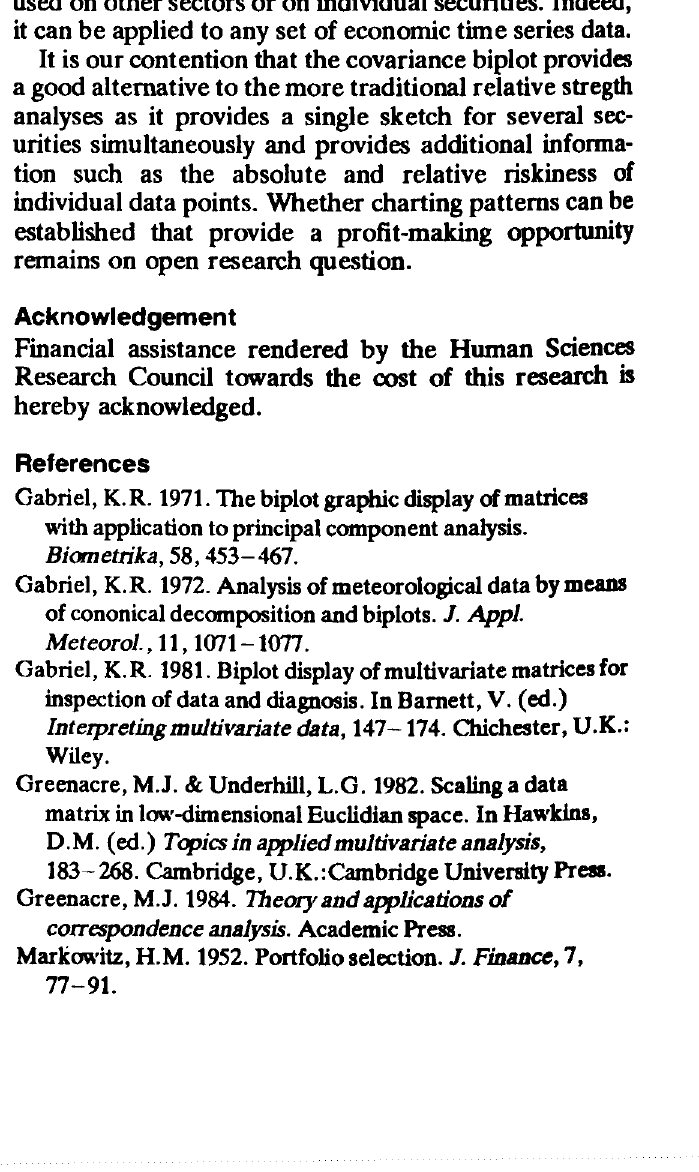
Figure 8 Relative movements from first half of 1983 to first half of